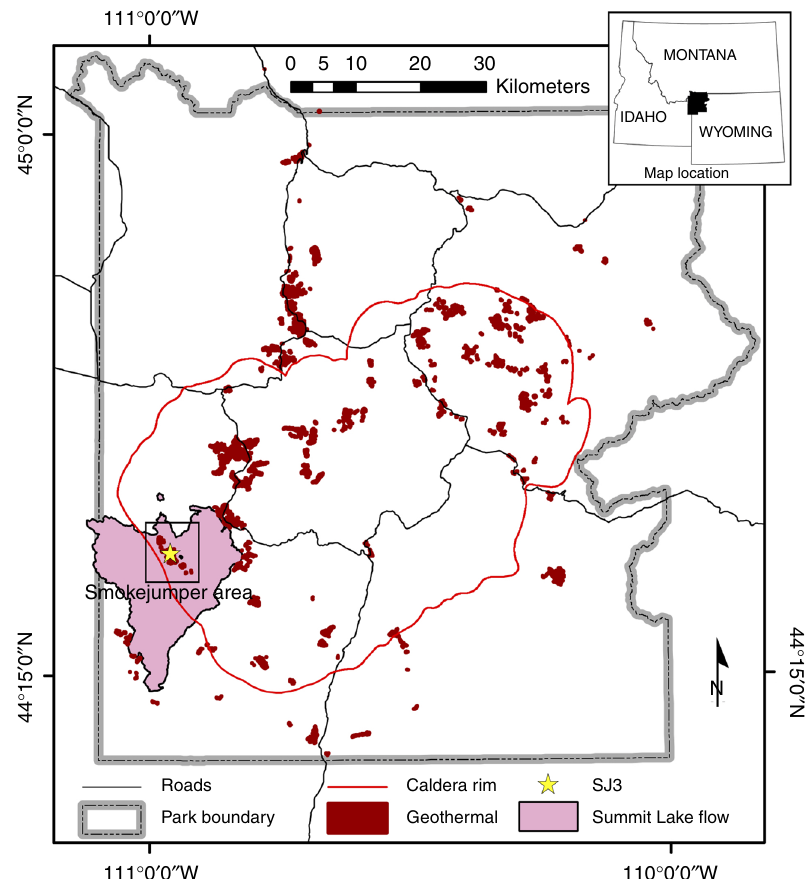
Fig. 1 Map of Yellowstone National Park (YNP) showing the location of the Smokejumper Geyser Basin (SJGB) and ‘ Smokejumper 3 ’ spring (SJ3). The caldera rim, road reference layers, park boundary, and Summit Lake Rhyolite Flow reference is the same as in Christiansen (2001)